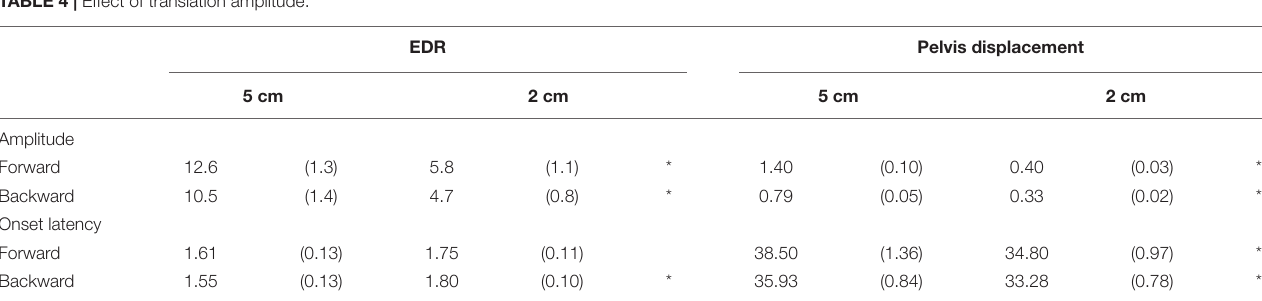
TABLE 4 | Effect of translation